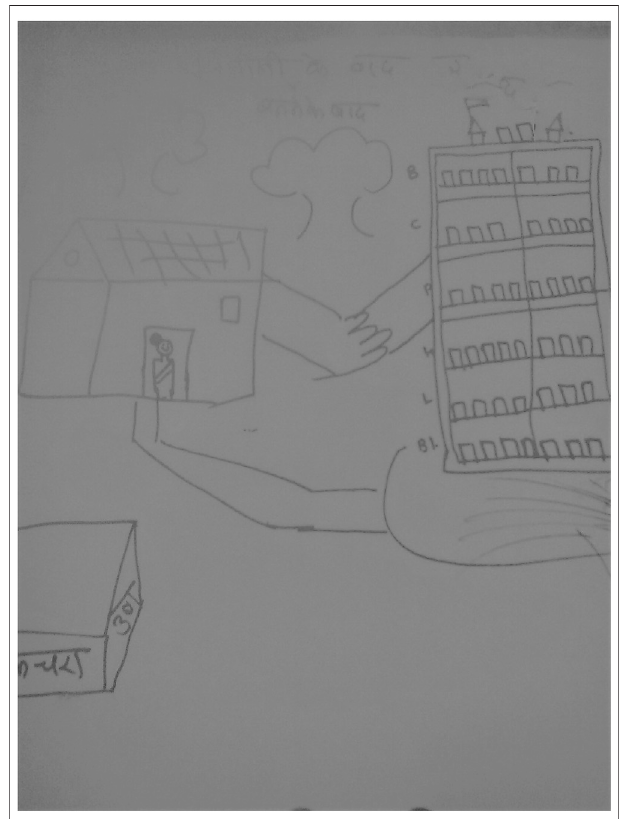
FIGURE 1 | Noori ’ s poster which shows the organization ’ s hand meeting with the community. Photograph by author. Note: the photograph has been altered to preserve participant con fi